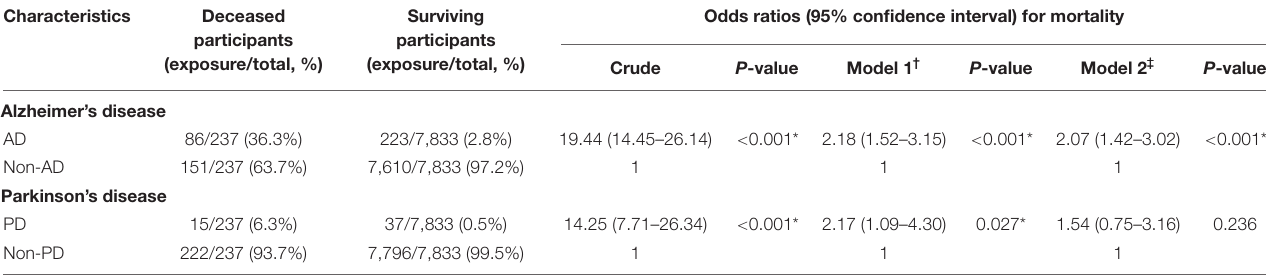
TABLE 4 | Crude and adjusted odds ratios of Alzheimer’s disease and Parkinson’s disease for mortality in COVID-19 participants.